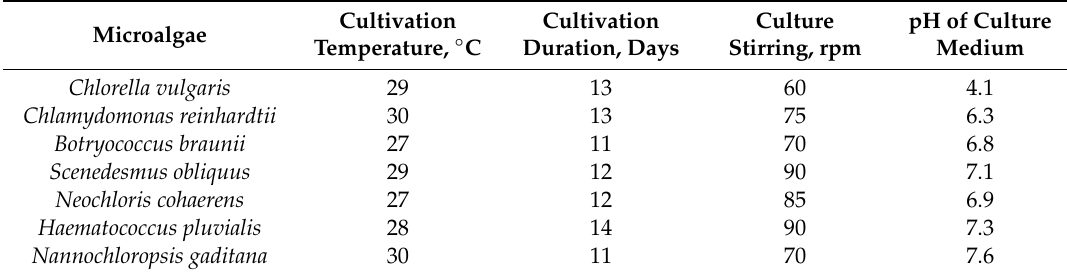
Table 5. Optimal conditions for growing microalgae biomass (table reconstructed using data from Nancucheo and Johnson